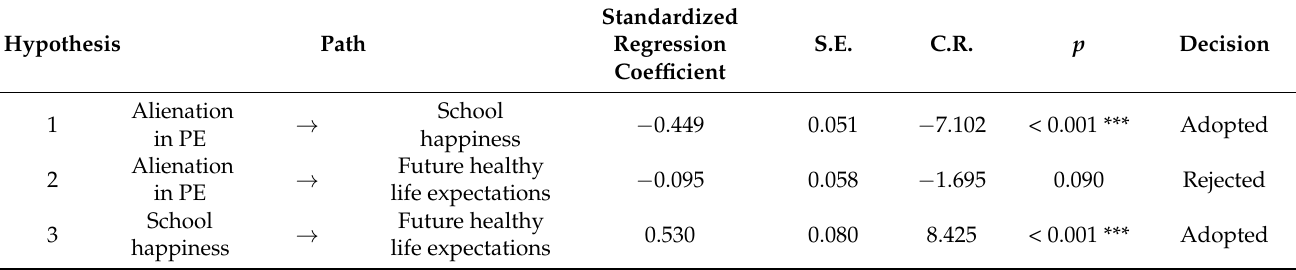
Table 3. Structural relationships among the study parameters before the COVID-19 pandemic. Hypothesis Path